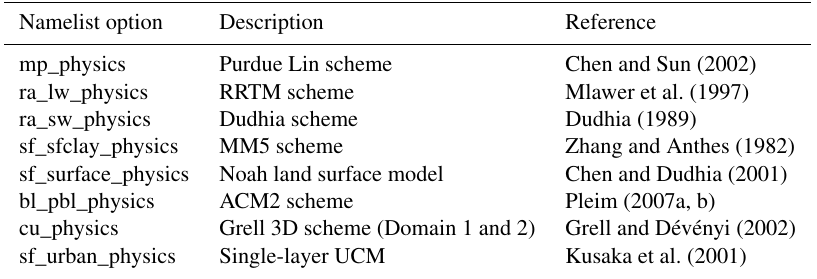
Table 1. Parameterizations used in the present model.